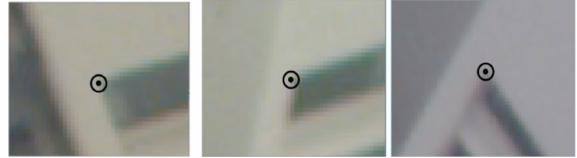
Figure 8. Left: 3D model of the window after its four corners have been measured. Right: automatically generated windows after the operator enters the vertical and horizontal window